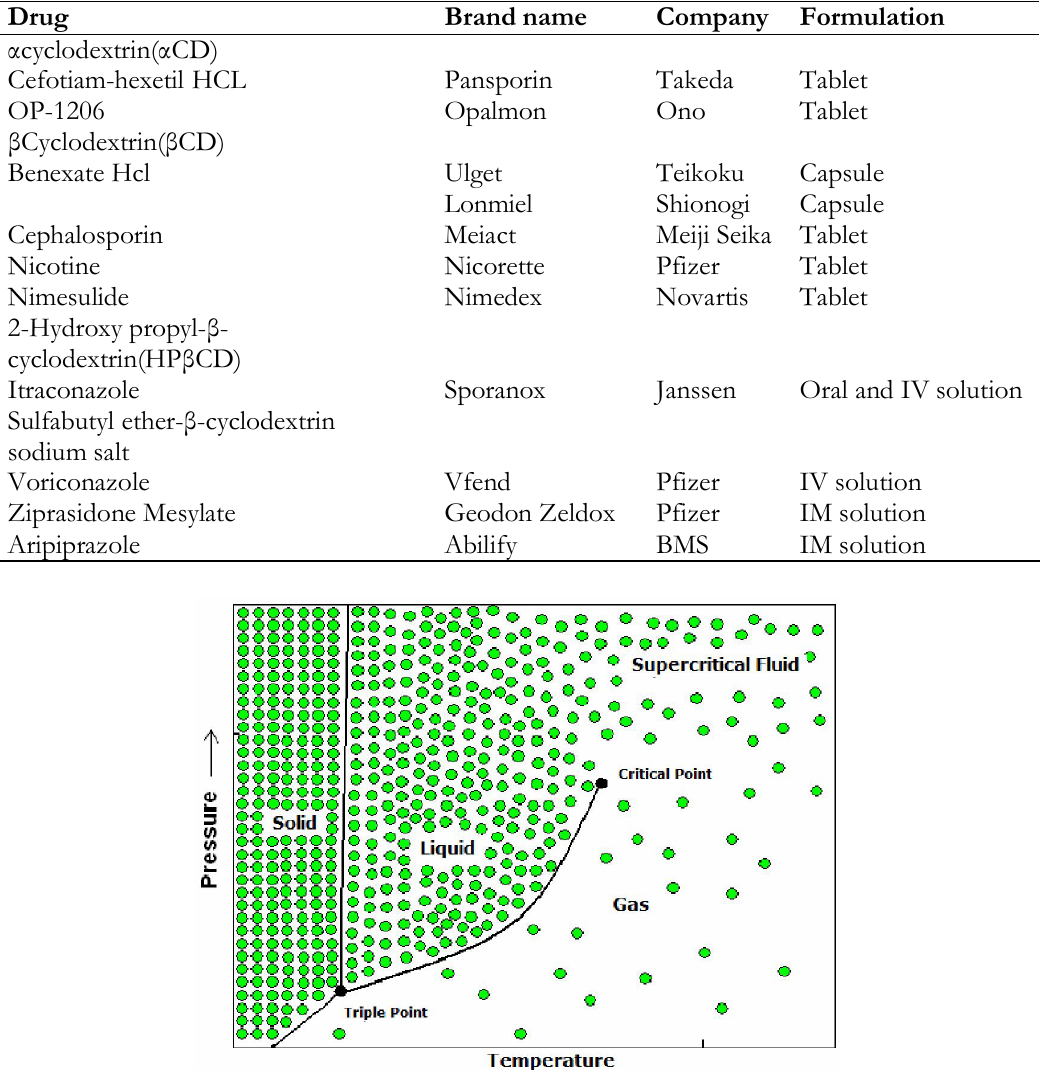
Table IV. List of marketed pharmaceutical containing cyclodextrins Drug